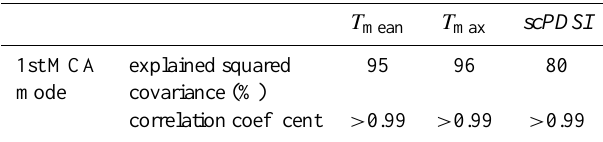
Table 1. A summery of the MCA analyses between P JFM and the forced manifolds.